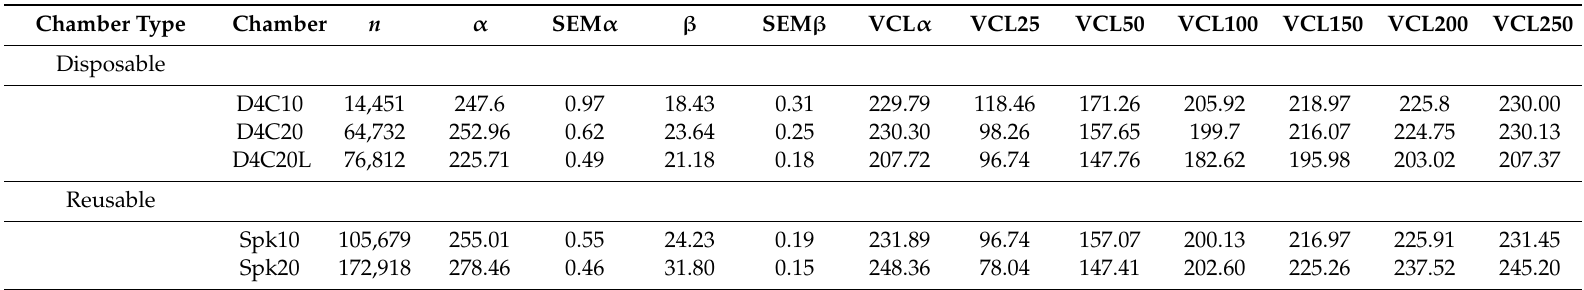
Table 1. Optimum frame rate calculated to have the threshold level for di ff erent chambers types and depths. Curvilineal velocity of donkey sperm for the optimal frame rate (VCL α ) and with di ff erent frames rates (25–250) calculated based on α and β